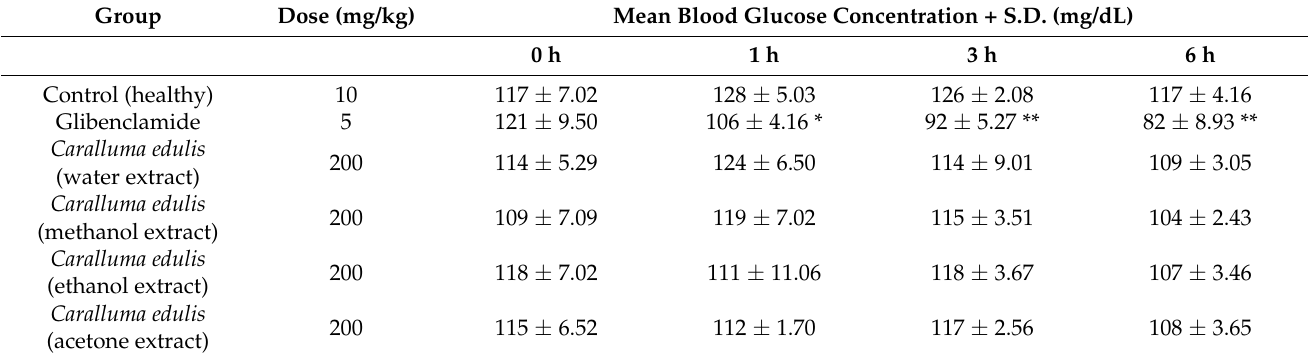
Table 6. Acute effect of Caralluma edulis extracts on blood glucose levels in alloxan-induced diabetic rabbits.